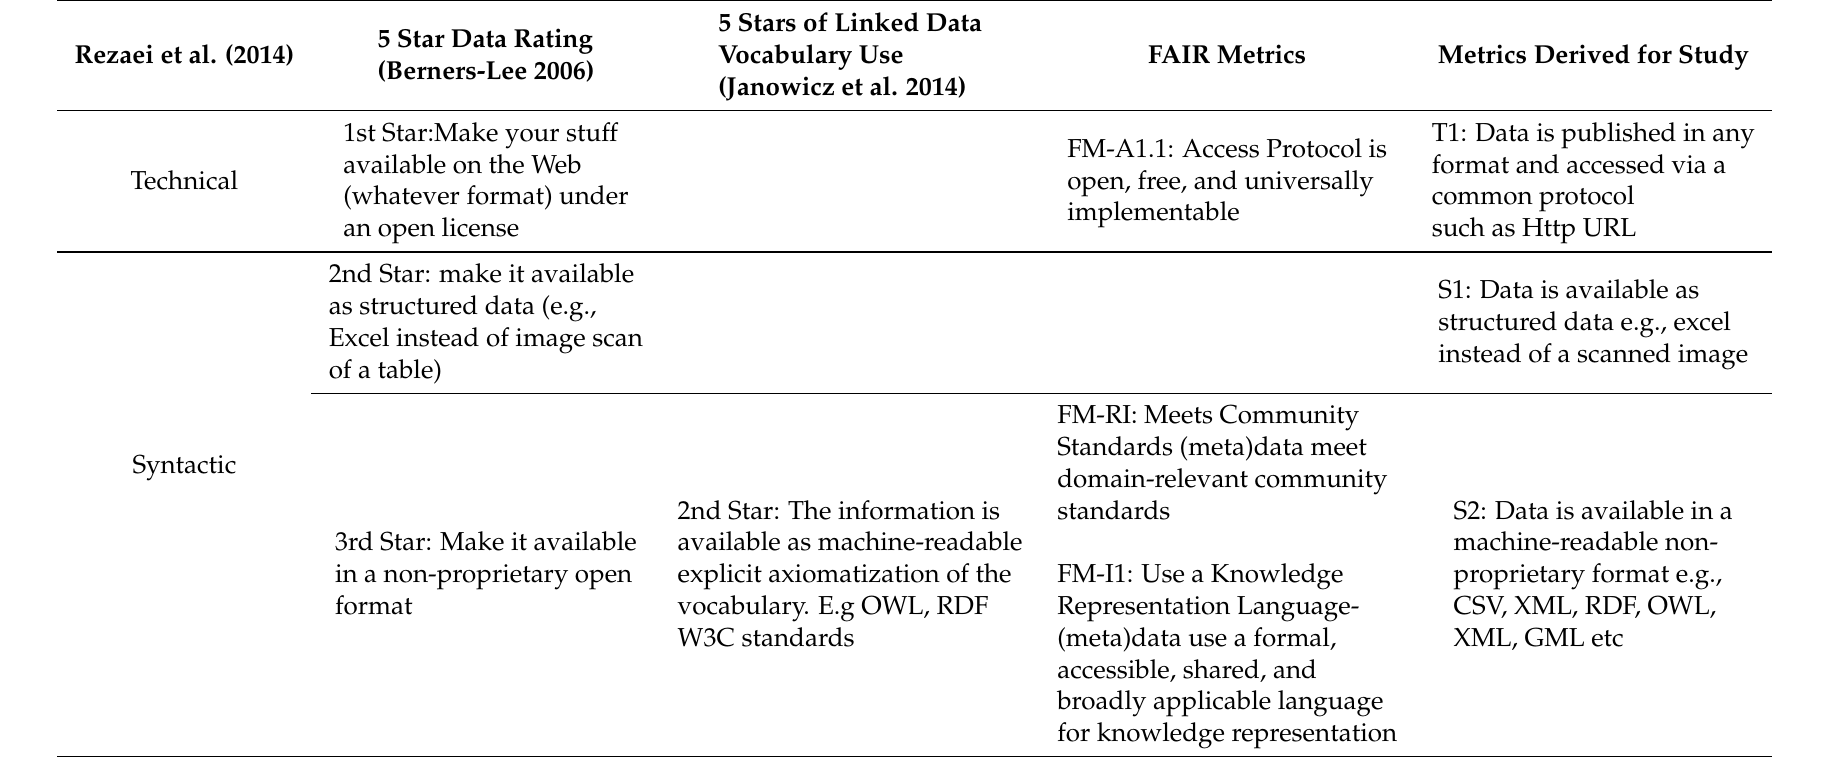
Table A1. Defining metrics for interoperability maturity